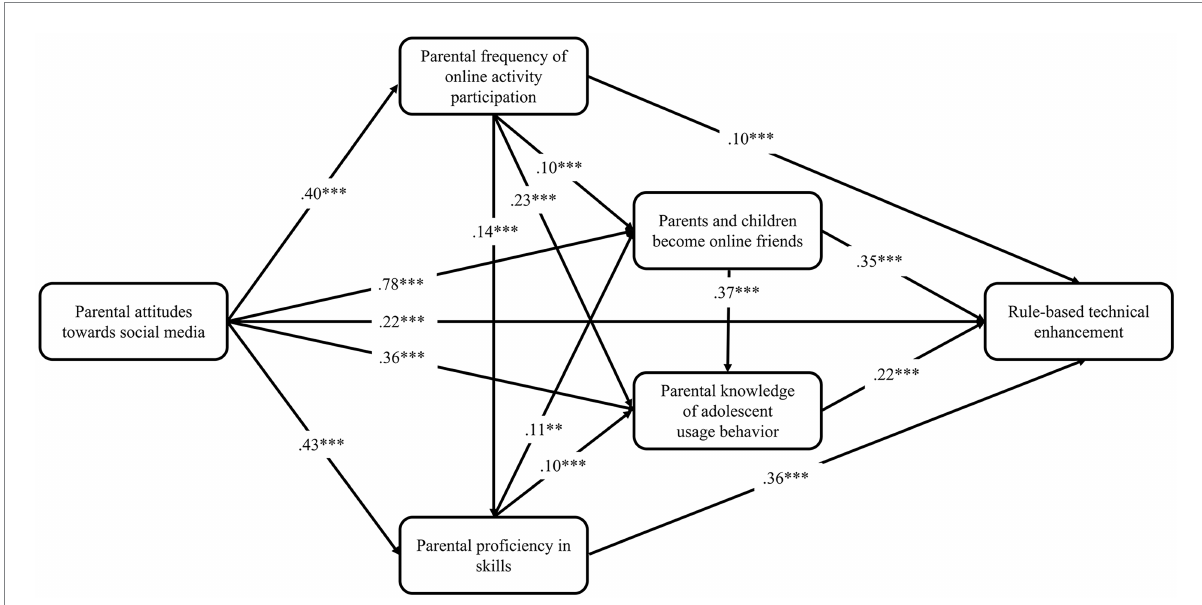
FIGURE 2 Predictive path coefficients of rule-based technical enhancement. * p < 0.05, ** p < 0.01, *** p <